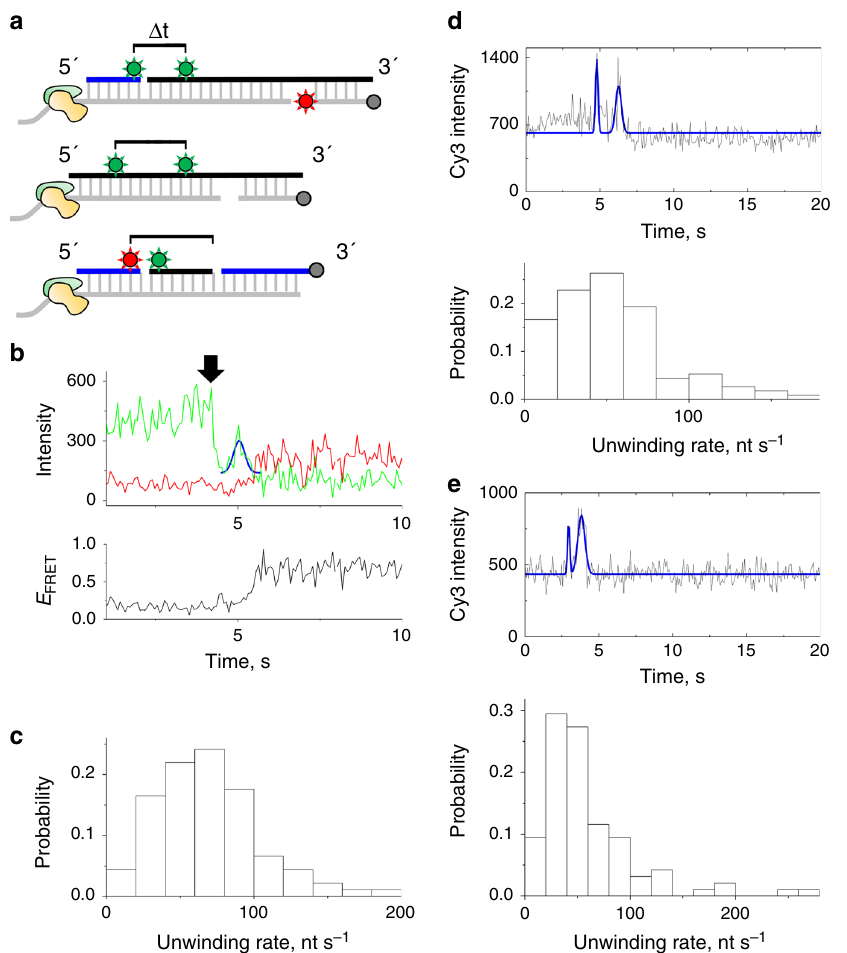
Fig. 5 Real-time helicase rate measurements. a Cartoon depicting the three constructs used for rate measurement experiments, either through the loss of Cy3 intensity and PIFE (top), two PIFE peaks (middle), or the loss of FRET and Cy3 intensity (bottom). The cartoon is depicted as in Fig. 1b, with DNA strands in gray, ZTP riboswitch-derived RNA strands in black, other DNA or RNA strands in blue, Cy3 and Cy5 dyes indicated by green and red circles, and biotin labels indicated by gray circles. b Individual single-molecule trajectory in the presence of 0.1 mM ZMP for the left scheme, using loss of Cy3 intensity and PIFE as time point indicators. The drop in Cy3 intensity is arrowed, and the PIFE peak fi t by a Gaussian curve (blue line). c Histogram of helicase rates obtained from all such experiments. The Δ t between intensity drop and PIFE peak is shown ( n = 91 molecules). d Individual single-molecule trajectory (top) and histogram of all helicase rates (bottom) for double PIFE experiment with Cy3 labels at U12 and U84 used as time point indicators. For the example trajectory, the raw data (black) and Gaussian fi ts of PIFE peaks (blue) are shown. The mean time difference ( Δ t) between PIFE peaks for experiments is 2.01 ± 0.20 s (mean ± standard error of the mean (s.e.m.), n = 95 molecules). e Individual single-molecule trajectory (top) and histogram of all helicase rates (bottom) for double PIFE experiment with Cy3 labels at U32 and U84. The mean Δ t between PIFE peaks is 1.64 ± 0.15 s (mean ± s.e.m., n = 112